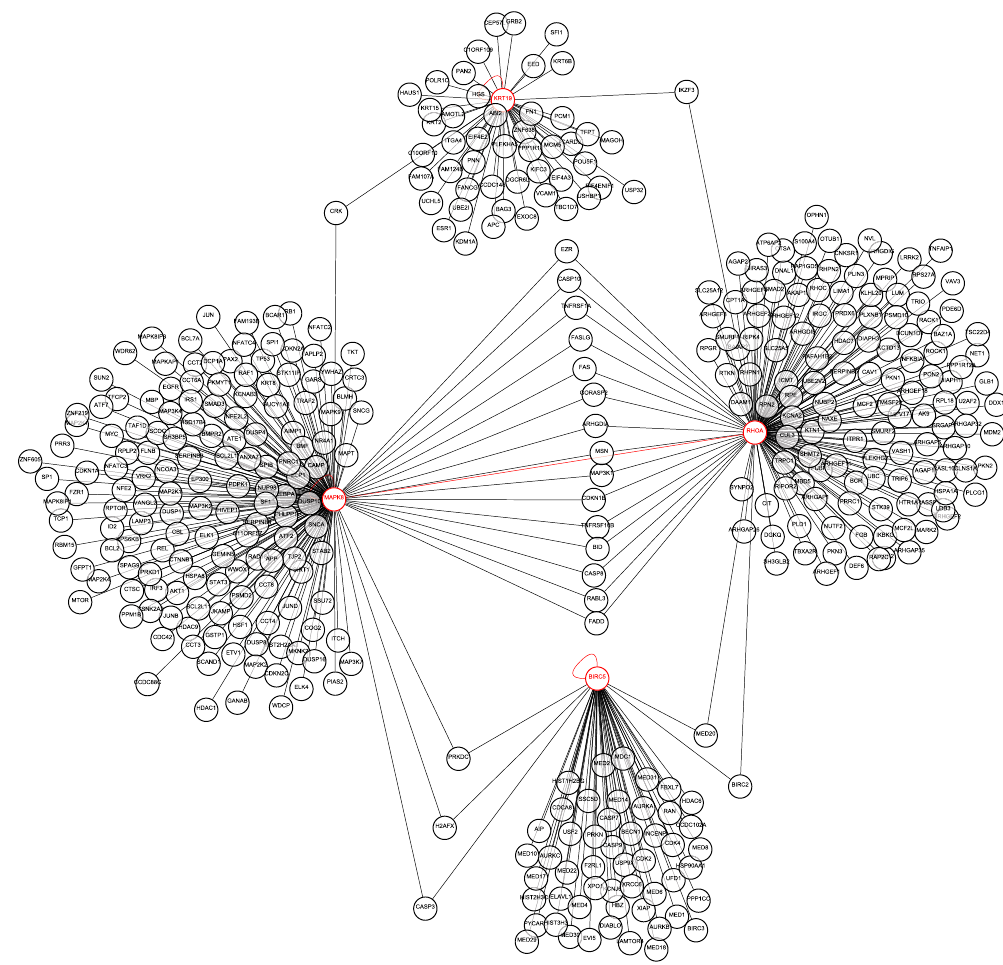
Figure 4. Enriched network of interactions among potential markers. Four genes ( RHOA , KRT19 , MAPK8 and BIRC5 ) highlighted in red were potential markers found in this study for non-invasive and early diagnosis of colorectal adenoma. The solid line represented interactions, and the red line represented a direct interaction between two potential